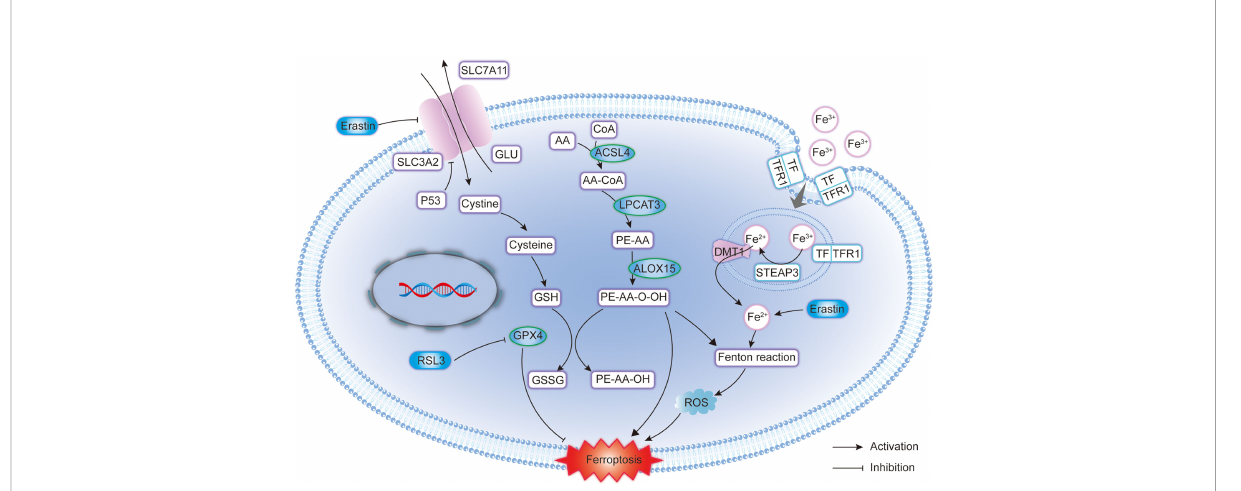
FIGURE 1 Molecular pattern diagram of ferroptosis in glioma. GPX4, Glutathione Peroxidase 4; SLC7A11, Solute carrier family 7 membrane 11; SLC3A2, Solute carrier family 3 membrane 2; GSH, Glutathione; GSSG, Glutathione disulphide; ACSL4, Acyl-CoA synthetase long-chain family member 4; ROS, Reactive oxygen species; DMT1, Divalent metal transporter 1; LPCAT3, Lysophosphatidylcholine acyltransferase 3; STEAP3, Six- transmembrane epithelial antigen of the prostate 3; TFR1, Transferrin receptor 1; TF, Transferrin; ALOX15, Arachidonate